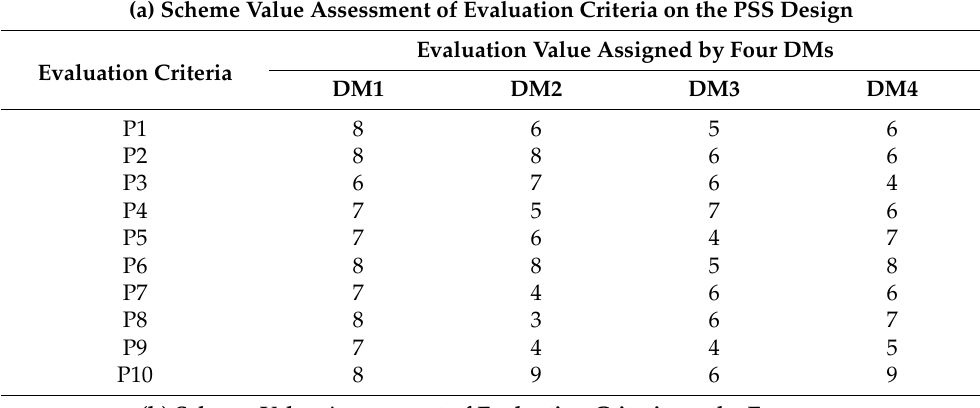
(b) Scheme Value Assessment of Evaluation Criteria on the Economy Evaluation Criteria